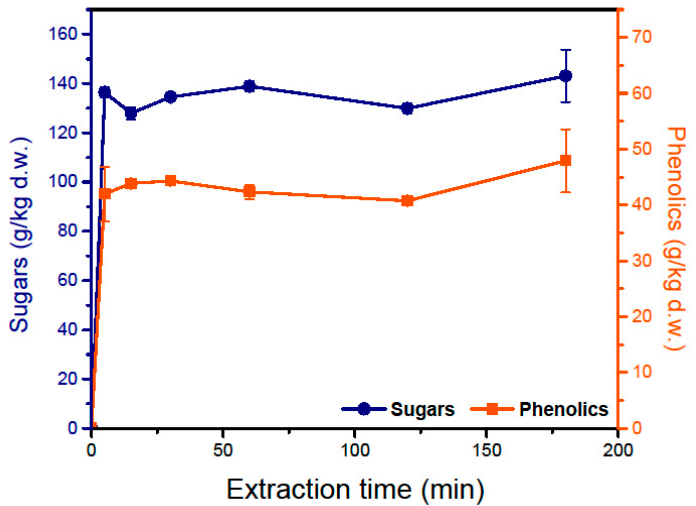
Figure 3. Effect of the duration of extraction on extracted sugars and phenolics; constant parameters: particle size < 0.71 mm, solid–liquid ratio 100 g/L, 40% ( v / v ) ethanol as the solvent, and room temperature.